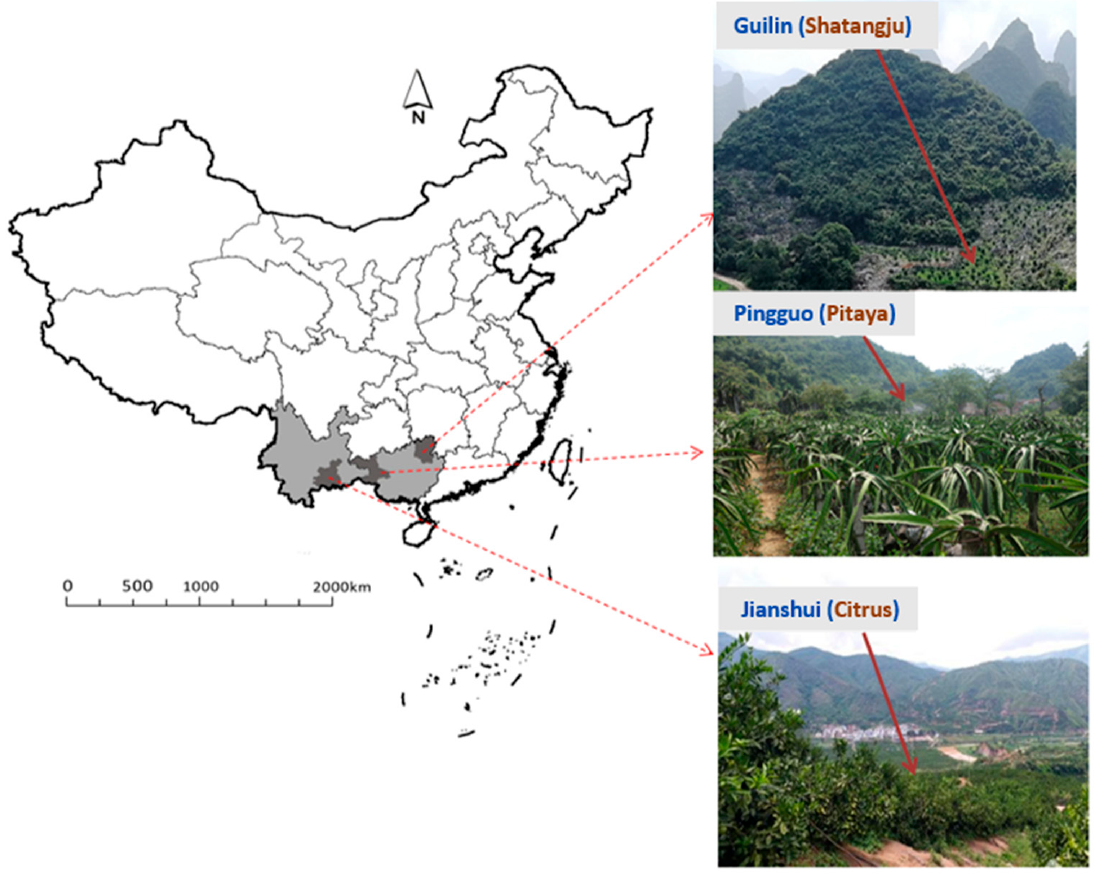
Figure 1. Location of three regions studied in the karst region of southwest